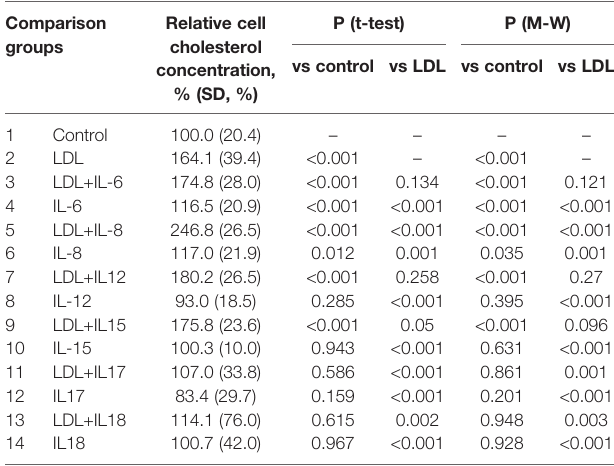
TABLE 1 | The effect of IL-6, IL-8, IL-12, IL-15, IL-17, IL-18 on the concentration of cholesterol in THP-1 cells. Comparison